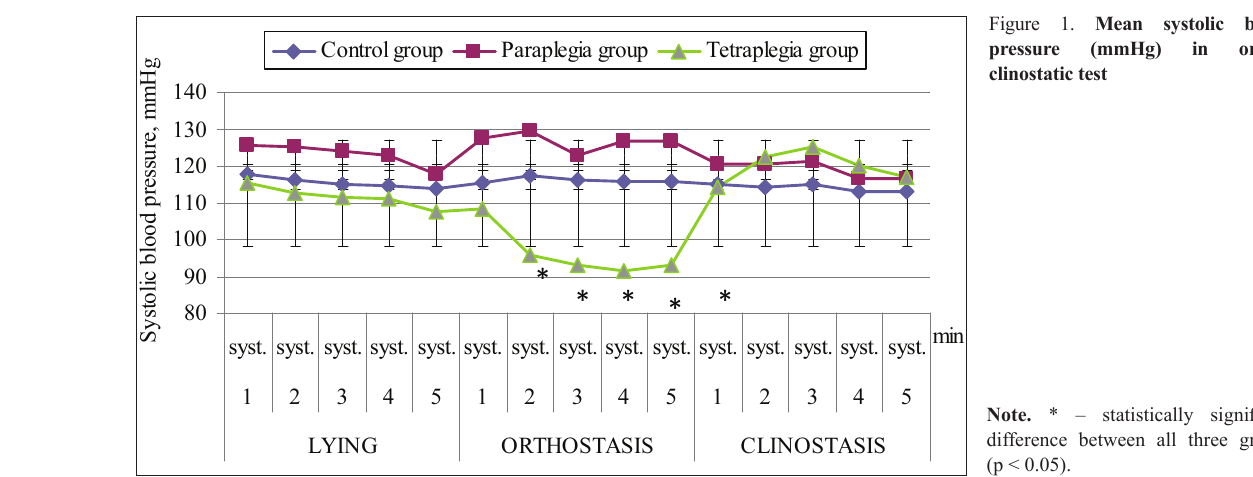
Figure 1. Mean systolic blood pressure (mmHg)